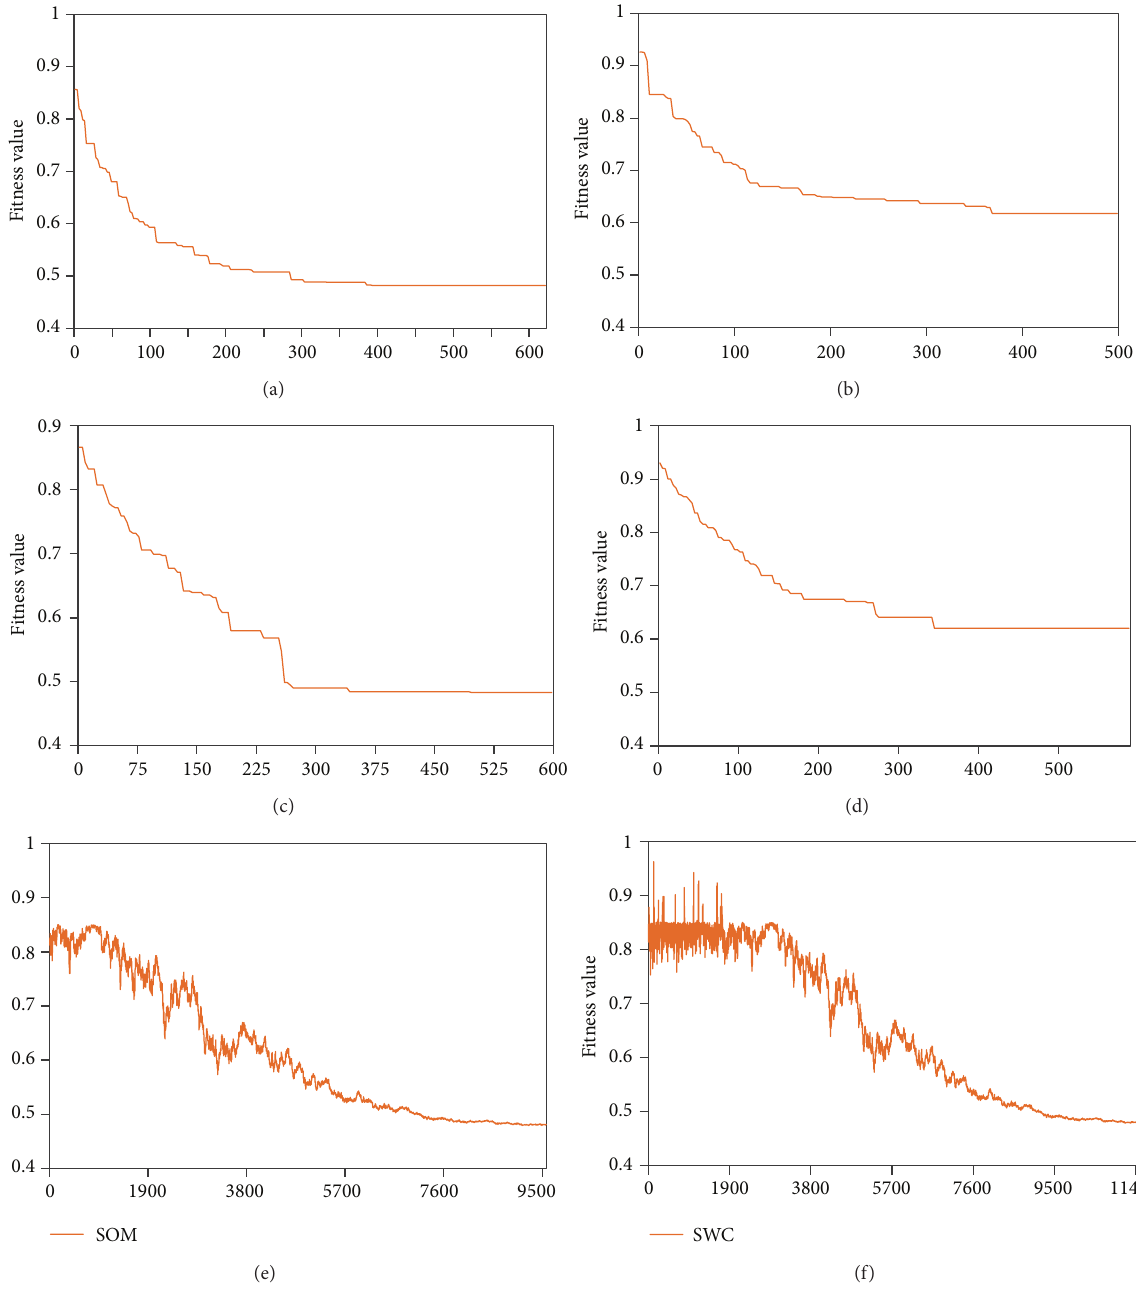
Figure 7: Comparisons of the algorithms equipped with a weighted fitness function: (a) and (b) for the MPSO, (c) and (d) for the BPSO, and (e) and (f) for the